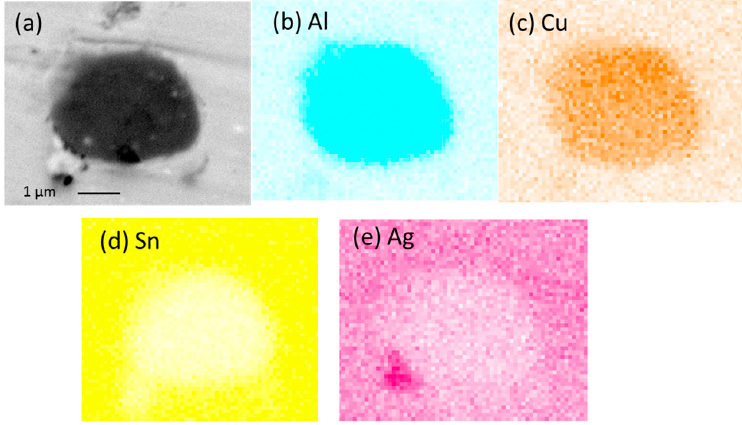
Figure 4. EDS line scan across equiaxed IMCs in SAC105 + 0.5Al.